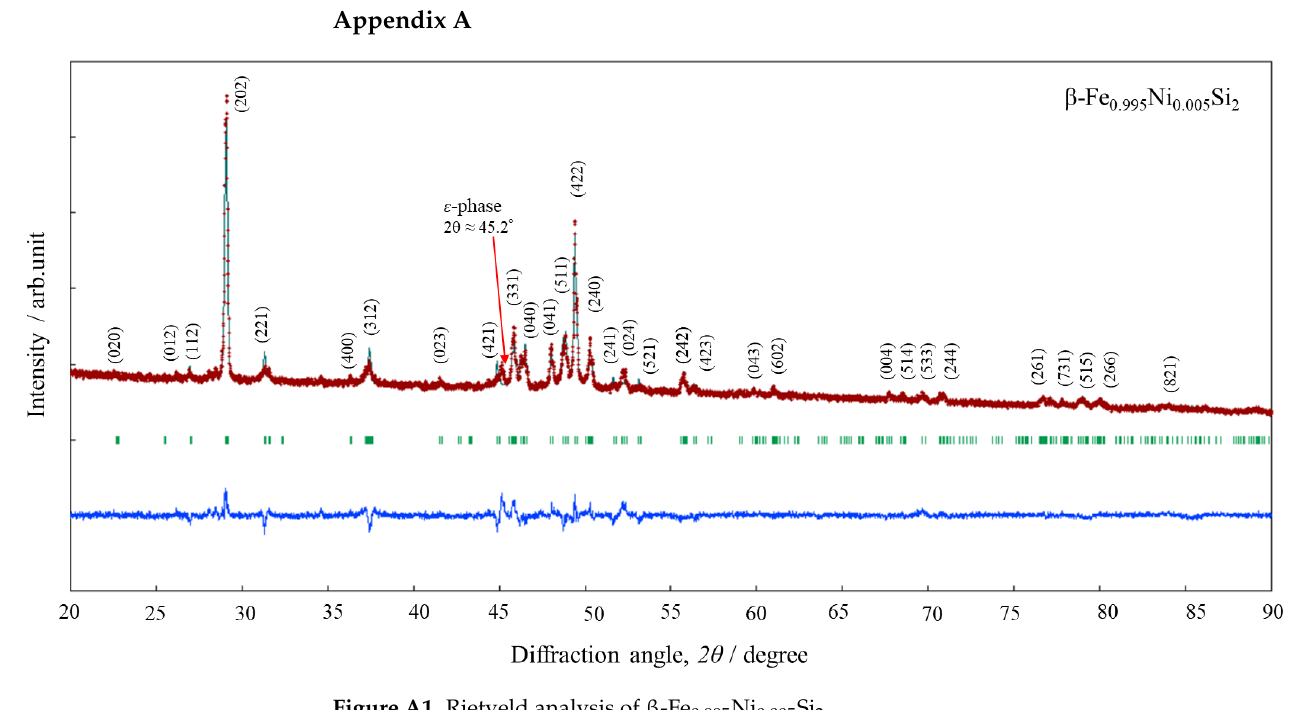
Figure A1. Rietveld analysis of β -Fe 0.995 Ni 0.005 Si 2 .